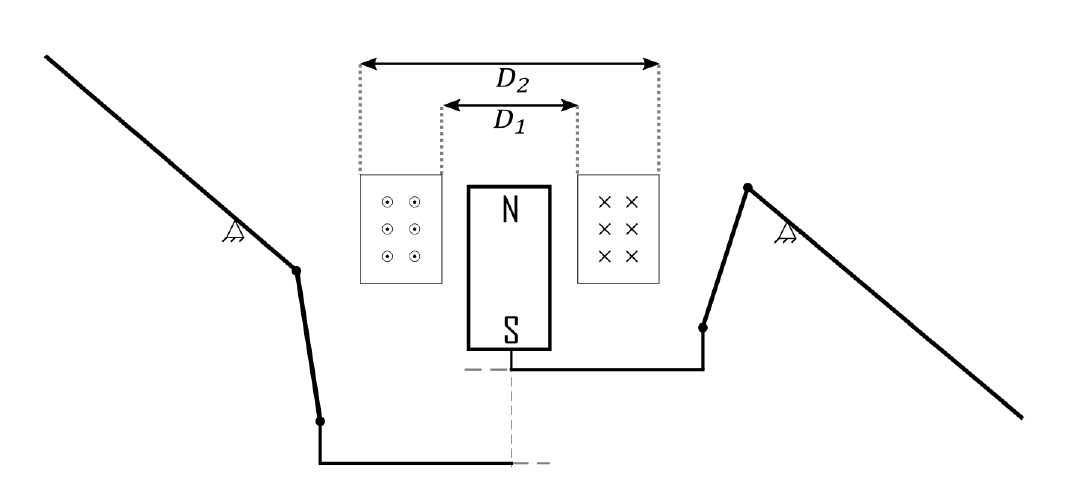
Figure 1. Flapping wing